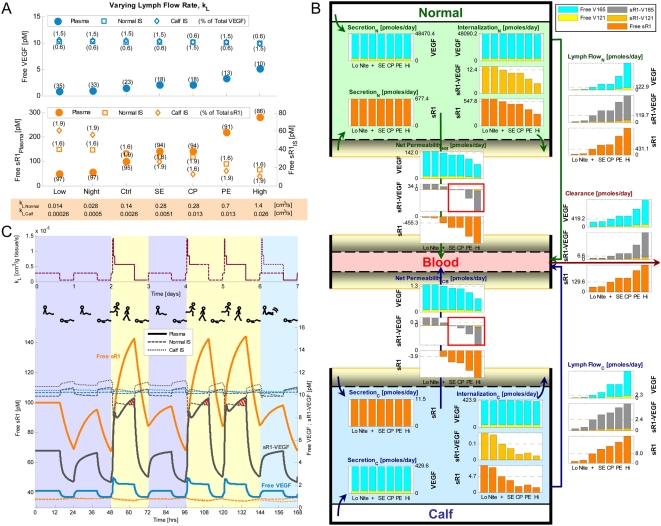
Steady-State and Dynamic Effects of Lymphatic Drainage Rates (kL).
Steady-state effects of kL on VEGF and sVEGFR1 concentrations (A) and flows (B). Of the three transport parameters (kP, kL, kCL), increasing kL over two orders of magnitude about the control value resulted in the greatest fluctuations in steady-state concentrations: most significantly elevating plasma VEGF and sVEGFR1, while lowering interstitial sVEGFR1. Exceptions were noted with localized changes in kL – e.g., with increasing only kL,Normal from ‘CP’ to ‘PE’, the enhanced flushing of sVEGFR1 from the local interstitium into the plasma eventually spilled over through increased sVEGFR1 extravasation into the opposite compartment to elevate interstitial sVEGFR1 concentration there. In addition, a reversal in permeability flow of sVEGFR1-VEGF complex (red box) was noted for kL above control. ‘Lo’ = low; ‘Nite’ = night; ‘+’ = supine awake (control); ‘SE’ = whole-body steady exercise; ‘CP’ = calf-only peak exercise; ‘PE’ = whole-body peak exercise; ‘Hi’ = high. Dynamic Effects of kL on VEGF, sVEGFR1, and sR1-VEGF Concentrations (C). kL-driven fluctuations in VEGF and sVEGFR1 attained within physiological diurnal cycles were less than those attained during steady-state analyses but still were of very wide ranges. “Bed-rest days” (purple columns) consisted of 15 hrs of wakefulness limited to supine or sitting postures, followed by 9 hrs of sleep. “Active days” (yellow columns) consisted of 15-hrs of activity starting off with a peak in kL during early exercise and settling down to a steady running/walking rate, followed by 9 hrs of sleep. Reversed permeability flow of sVEGFR1-VEGF complex (red cross-hatching) was observed in the latter active waking hours. “Calf-limited activity days” (aqua column) are same as “bed-rest days” except that active kL was induced in the calf during the first 15 hrs of wakefulness. Stick-figure illustrations adapted from Olszewski et al. Lymphology 1977, 10(3):178–183.